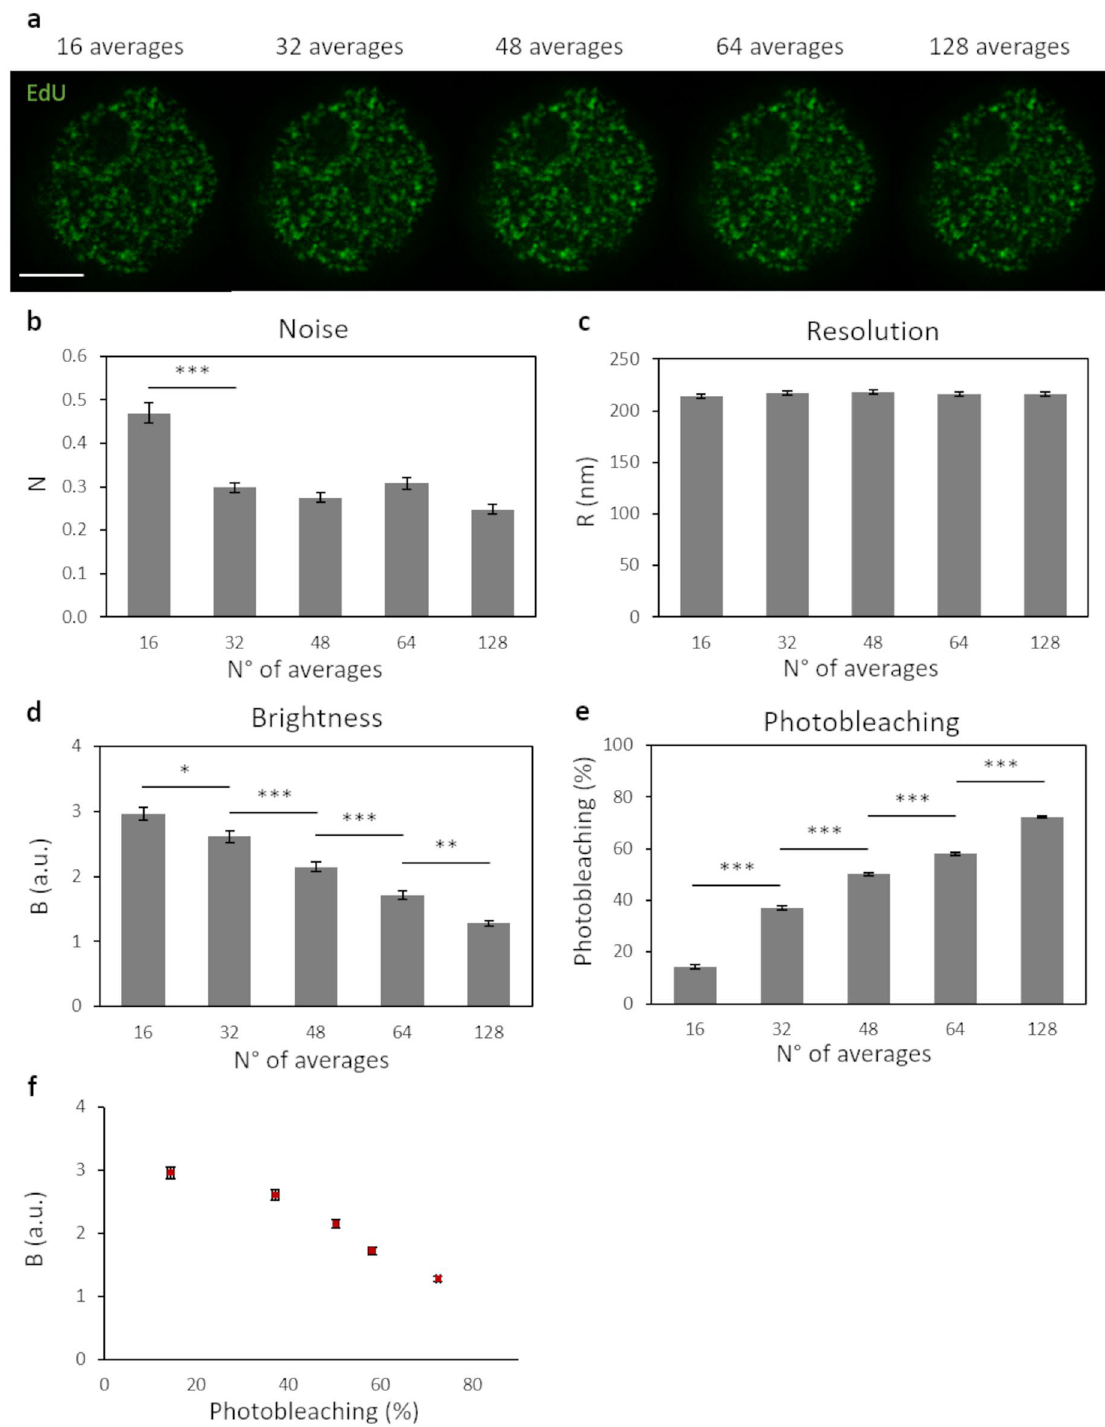
Figure 3. Increasing number of scans average per line. ( a ) Representative images of U937-PR9 cells upon staining of DNA replication foci. Each image is obtained by combining and averaging STED images after each acquisition step of increasing number of line-averages (see “Methods” for a detailed description of acquisition settings) Scale bar represents 3 µm. ( b – d ) Quantification of Resolution, Brightness and Noise parameters in function of the number of line-averages by application of the QuICS algorithm. At least ten images for each condition have been acquired. ( e ) Quantification of Photobleaching in function of the number of line-averages. Photobleaching was calculated as the percentage reduction of average fluorescence intensity with respect to the initial value. ( f ) Representation of the Brightness variation in function of the Photobleaching. At least ten images for each condition have been quantified. Error bars represent the SEM and ***p < 0.001, **p < 0.01, *p <